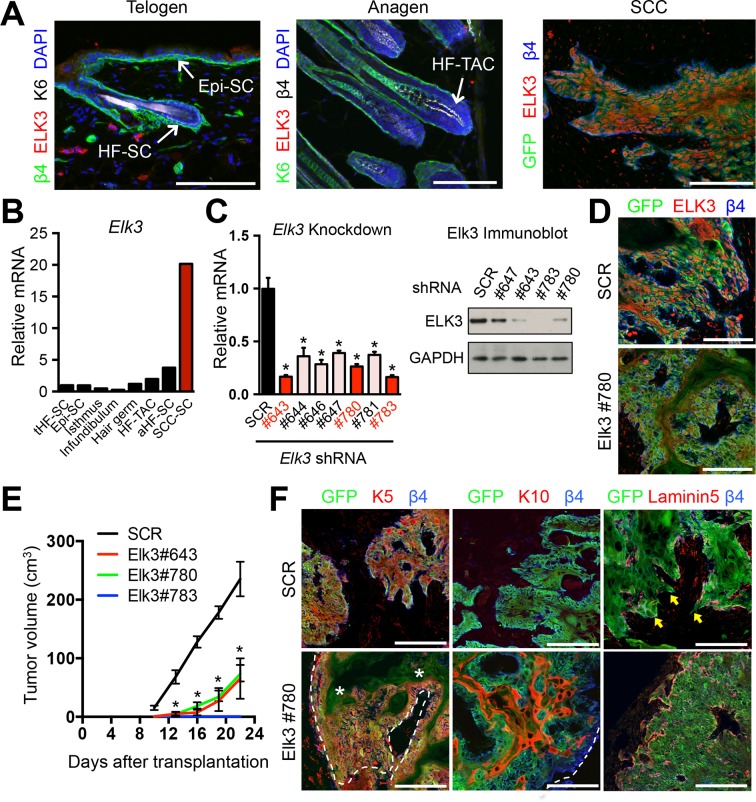
ELK3 is specifically induced in SCC-SCs and promotes SCC growth.(A) Immunofluorescence analysis showing that ELK3 is absent in normal skin epithelia but expressed in SCC-SC-derived allograft tumors. Epi-SC, epidermal basal cells; HF-SC, hair follicle stem cells; HF-TAC, short-lived, transit-amplifying cells. Scale bars, 100 μm. (B) Elk3 gene expression is low or absent in normal skin cells but specifically induced in SCC-SCs. Telogen(t) and anagen(a) HF-SCs; isthmus, infundibulum, and hair germ are other progenitor compartments of the HF. (C) (left) Knockdown efficiency of Elk3 shRNAs in HRasG12V; Tgfbr2-null cells as measured by quantitative RT-PCR. (n = 3 ± SEM; *p<0.05). (right) Immunoblot analyses confirming that changes in mRNA levels are reflected at the level of protein. (D) Immunofluorescence image of allograft tumors (GFP) from control and Elk3-knockdown SCC-SCs. Scale bars, 100 μm. (E) Changes in tumor volume of Elk3 knock-down and control allografts over time (n = 3). (F) Immunofluorescence images of Elk3 knock-down allograft tumor (GFP) showing reduced numbers of undifferentiated keratin 5 (K5) cells, appearance of keratinized pearls of cells expressing differentiation marker keratin 10 (K10), and diminished signs of basement membrane breakdown (as judged by laminin 5) and of invasion at the tumor-stromal interface. Asterisks mark absence of K5 in keratinized pearls. Dotted line marks tumor-stromal boundaries. Arrows denote invasive tumor cells at signs of discontinuous basement membrane. Scale bars, 100 μm. HF, hair follicle; SC, stem cell; SCC squamous cell carcinoma.